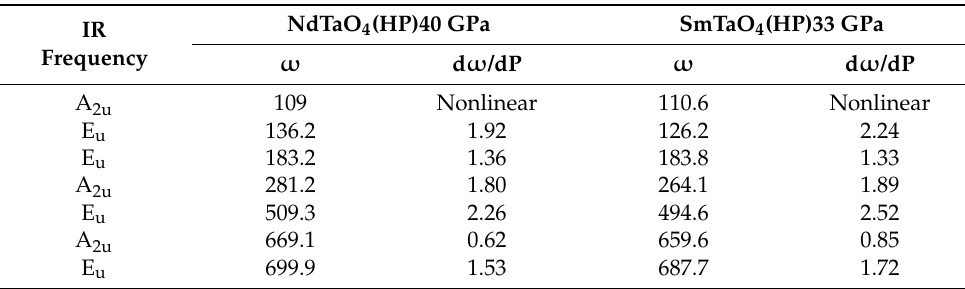
Table 6. Calculated IR modes for NdTaO 4 and SmTaO 4 at 40 and 33 GPa along with their pressure coefficients (present